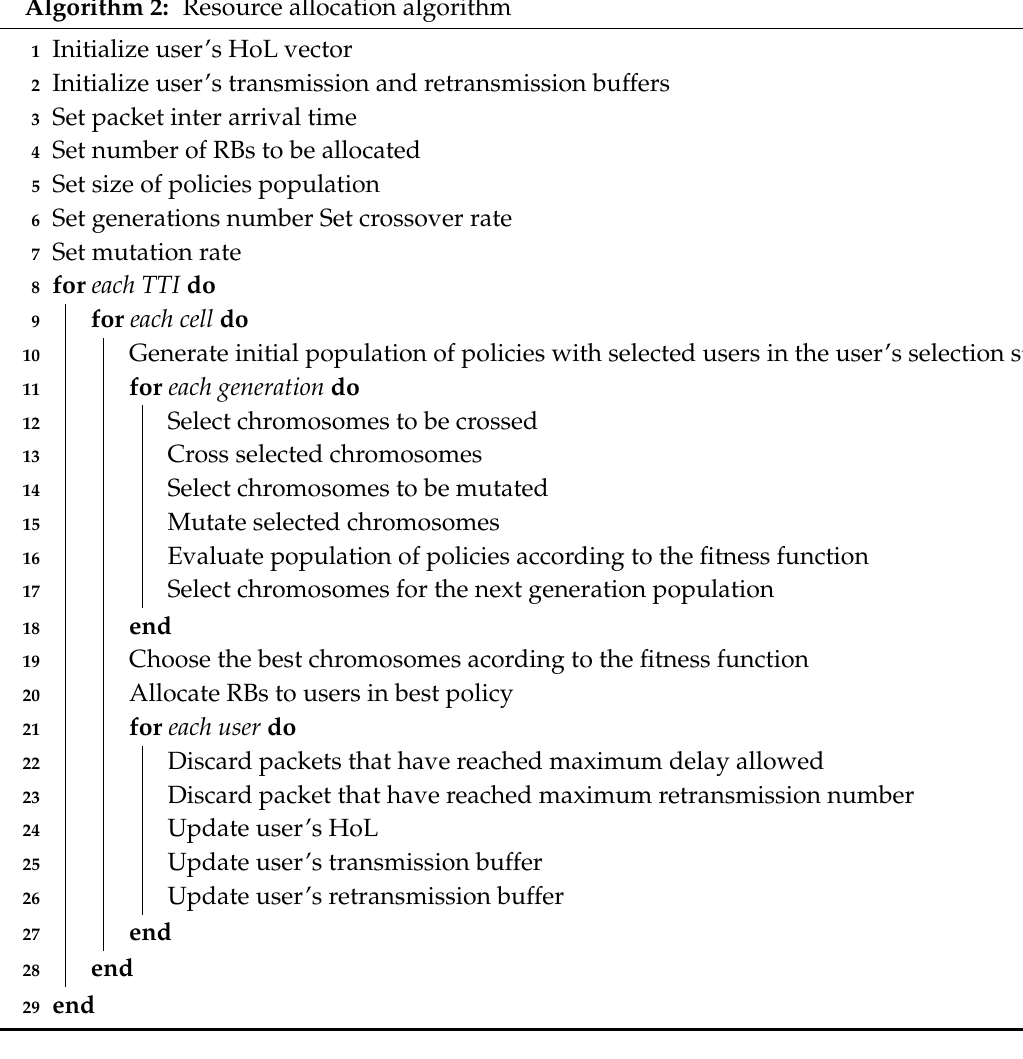
Algorithm 2: Resource allocation